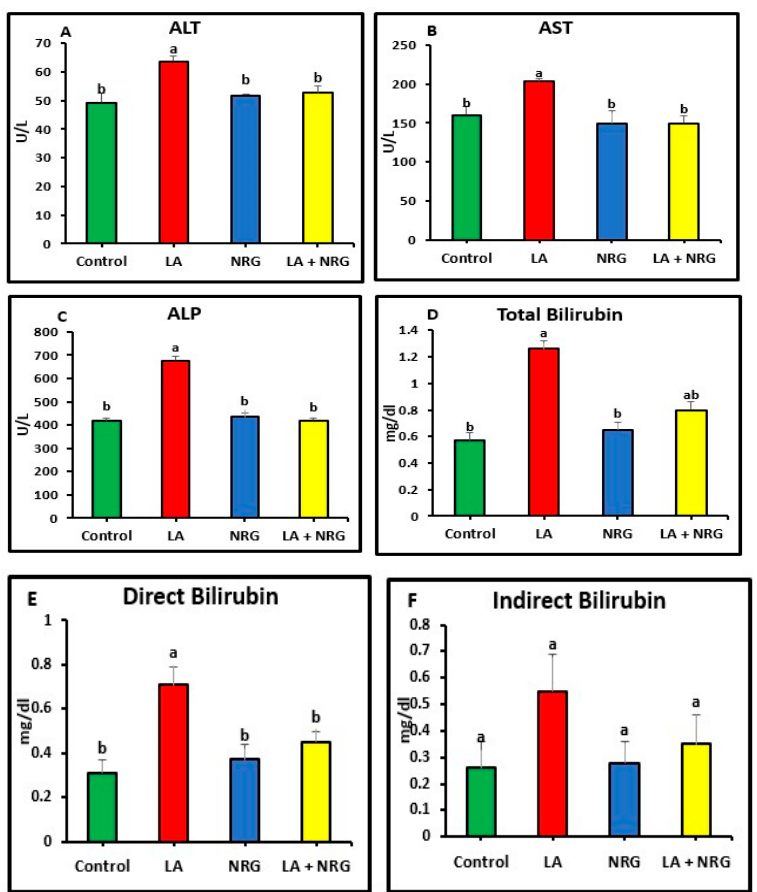
Figure 1. Liver function parameters: ( A ) AST (U/L), ( B ) ALT (U/L), ( C ) ALP (U/L), ( D ) total (mg/dL), ( E ) direct bilirubin (mg/dL), and ( F ) indirect bilirubin (mg/dL) at the 4th week of treatment of LA-intoxicated rats with NRG (mean ± SE)). The means in each chart with di ff erent superscripts are signi fi cantly di ff erent ( p < 0.05). ALT: alanine aminotransferase; AST: aspartate aminotransferase; ALP: alkaline phosphatase. a for the high value; while b for the lower value.